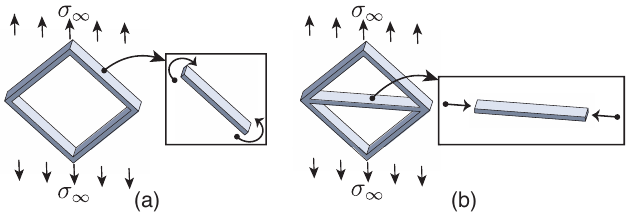
Figure 4. Schematic of ( a ) bending-dominated and ( b ) stretch-dominated